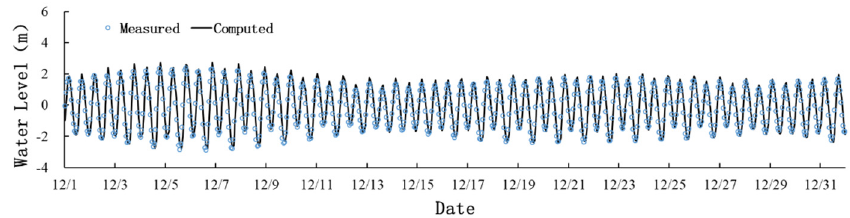
Figure 3. Validation of water level.